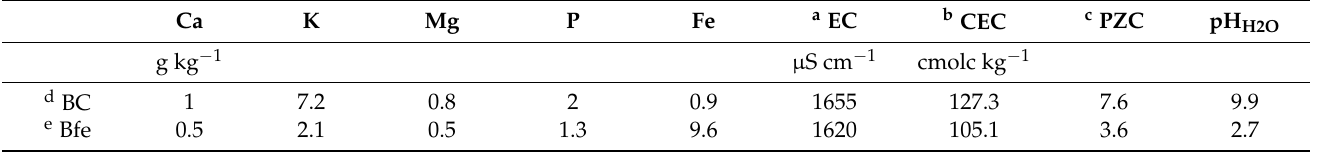
Table 3. Characterization of